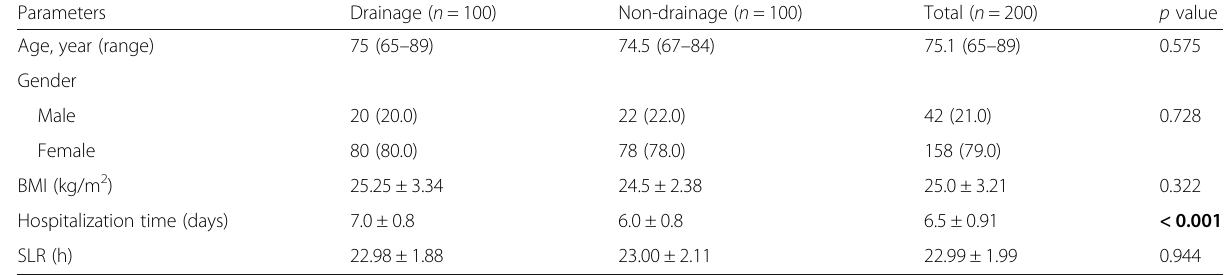
Table 1 Clinical characteristics of included patients